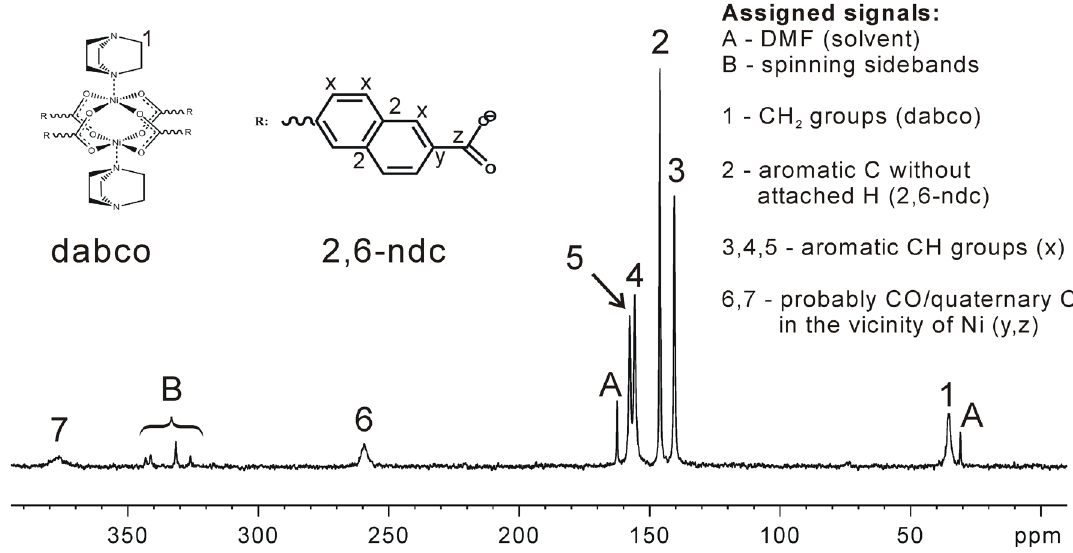
Figure 4. Assignment of the signals to the carbon atoms present in resolvated DUT-8(Ni) (Reproduced with permission from [24], copyright 2012 the Royal Society of